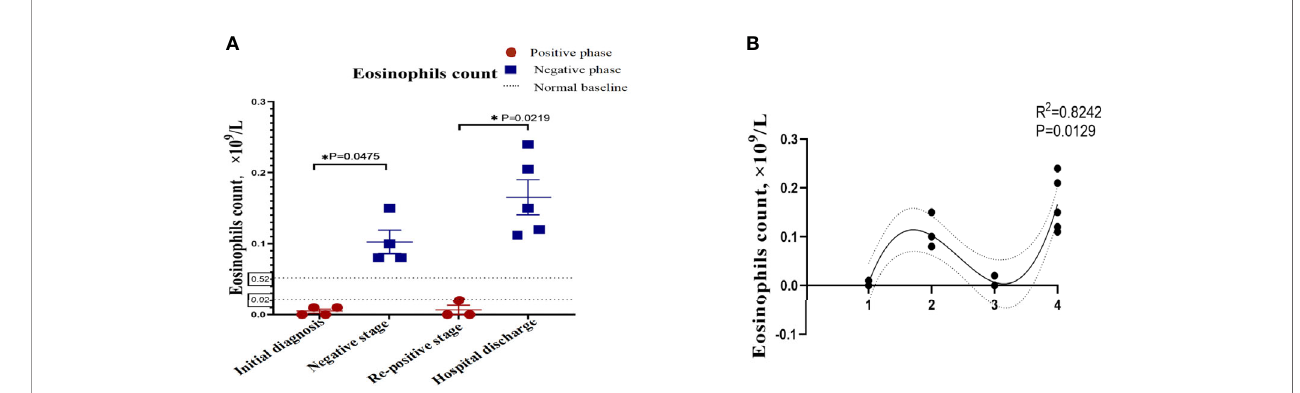
FIGURE 2 | The indicators of signi fi cant difference between patients with and without re-positive. Re-positive patients had lower serum creatinine concentrations (A) and albumin concentrations (B) at the time of initial admission than did recovered patients. Yellow represents the re-positive patients, and blue represents the recovered patients. all quanti fi cation graphs represent mean